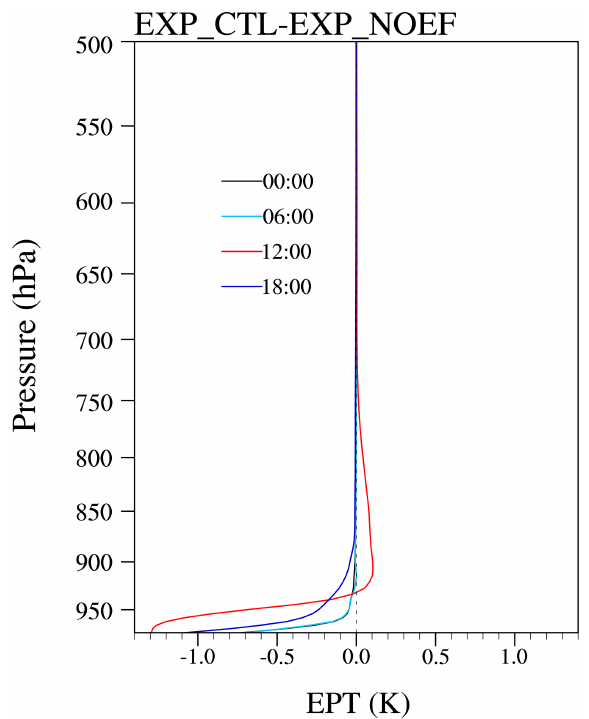
Figure 9. Aerosol impact on equivalent potential temperature (EPT, K) profiles at 00:00, 06:00, 12:00, and 18:00 averaged for the BTH region and the period 10–15 January 2013.